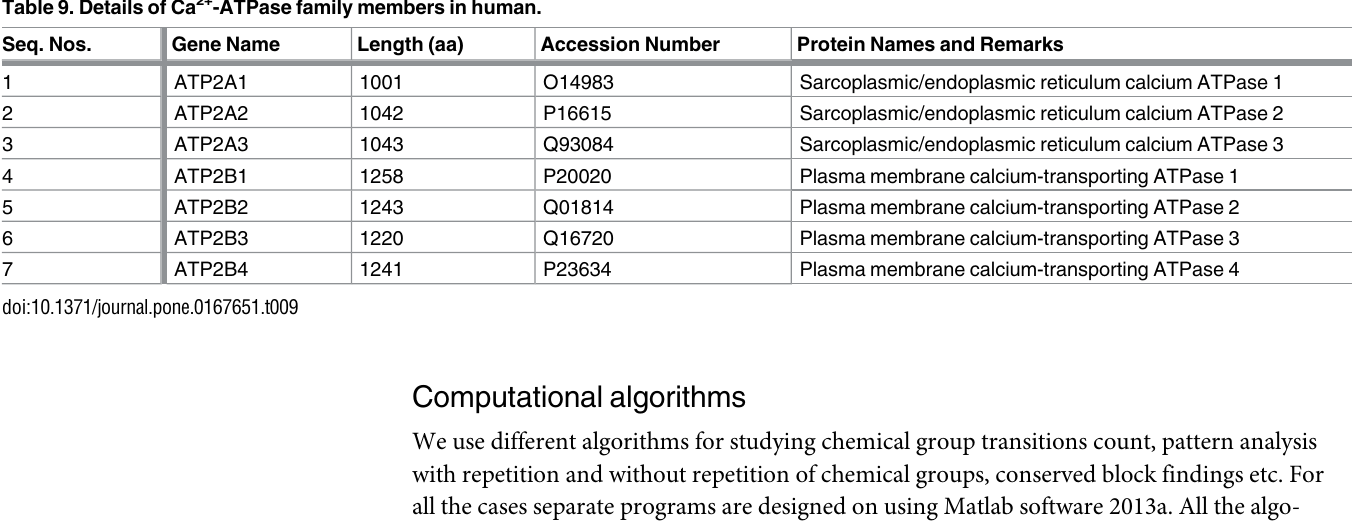
Algorithm 1: Chemical group transitions and ordered pair analysis. This algorithm is